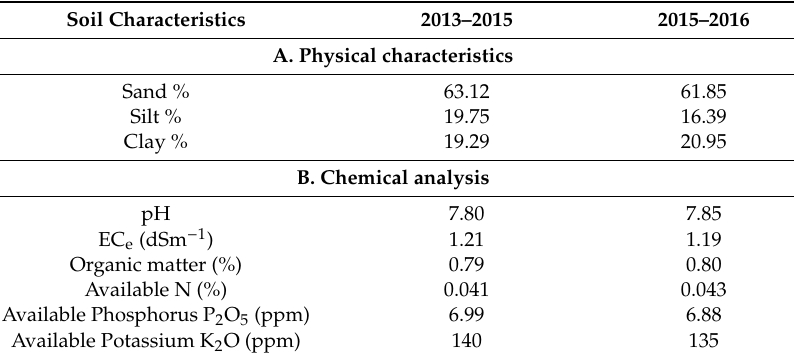
Table 1. Soil analysis of the experimental